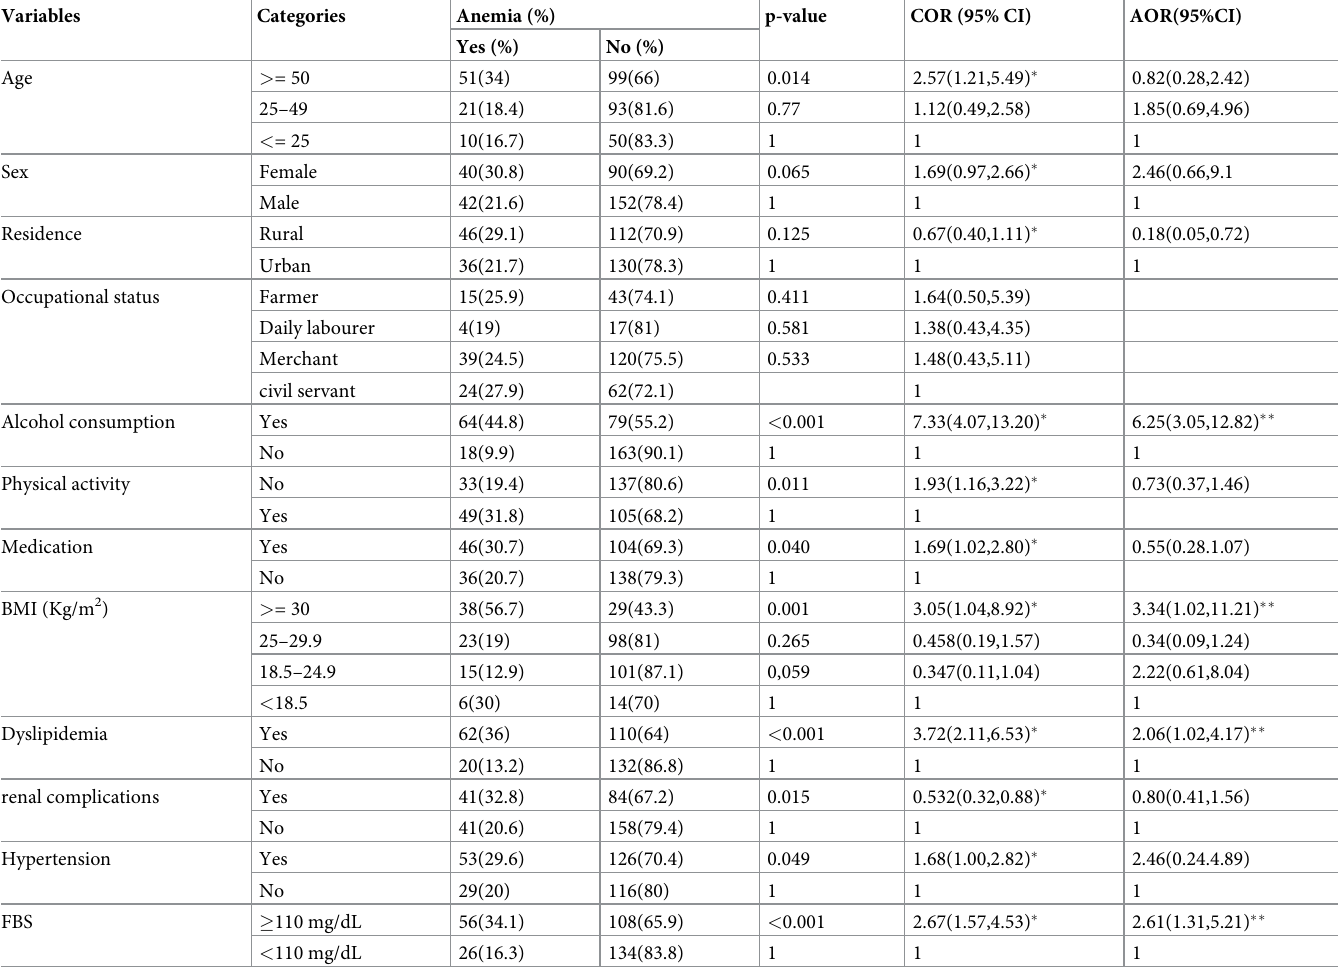
Table 3. Bivariable and multivariable analysis of factors associated with anemia among admitted MetS patients attending Worabe Comprehensive Specialized hos- pital, Southern Ethiopia from March 1 to May 30,